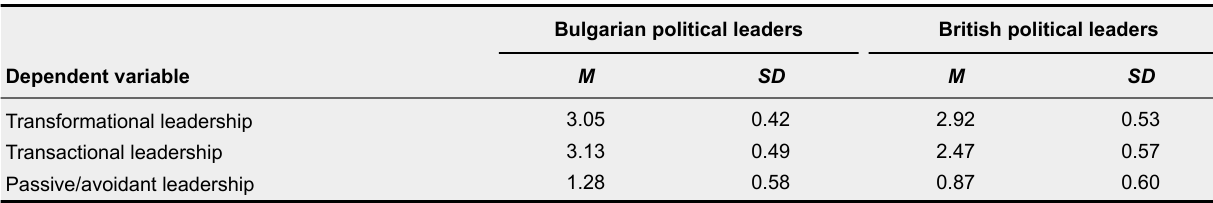
Means and Standard Deviations for the Three MLQ Leadership Style Frequency Scores for Bulgarian (N = 63) and British (N = 77) Political Leaders